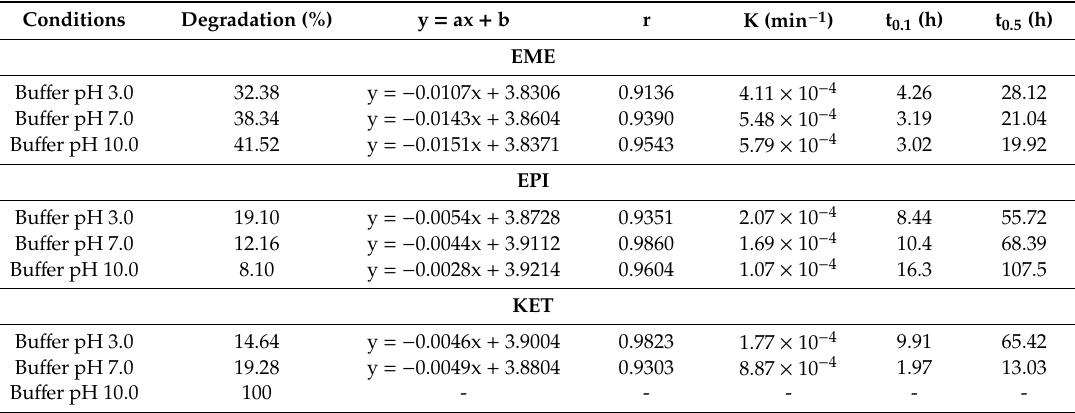
Table 2. Kinetics of the photodegradation of emedastine (EME), epinastine (EPI), and ketotifen (KET) in bu ff er solutions ( n =